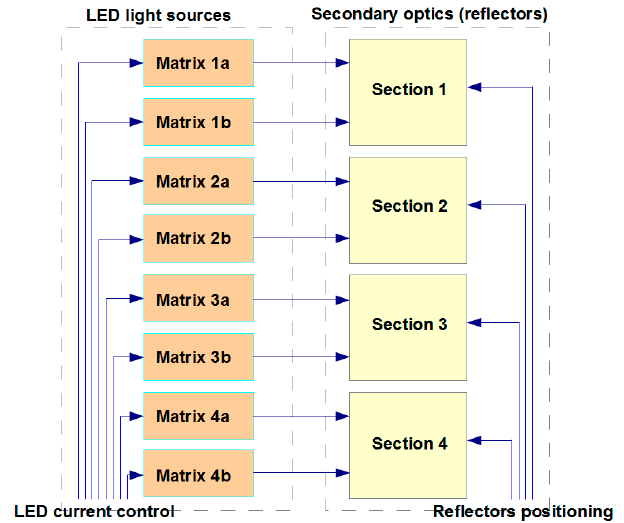
Figure 8. Diagram of the luminaire’s control system.